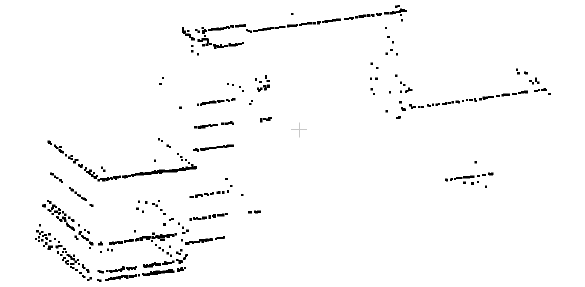
Figure 5: Edge detection result from the terrestrial Data